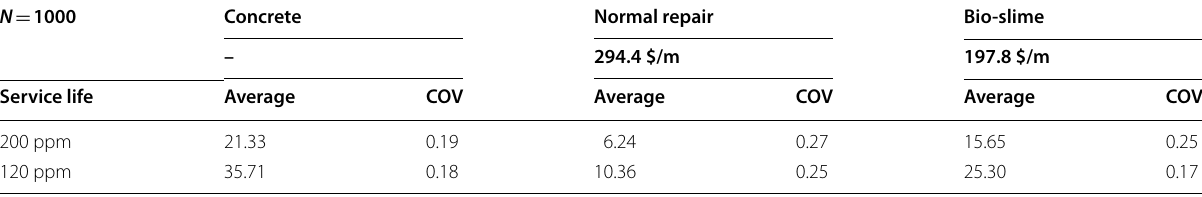
Table 3 Initial and extended service life and their COV with different repair technique. N 1000 =